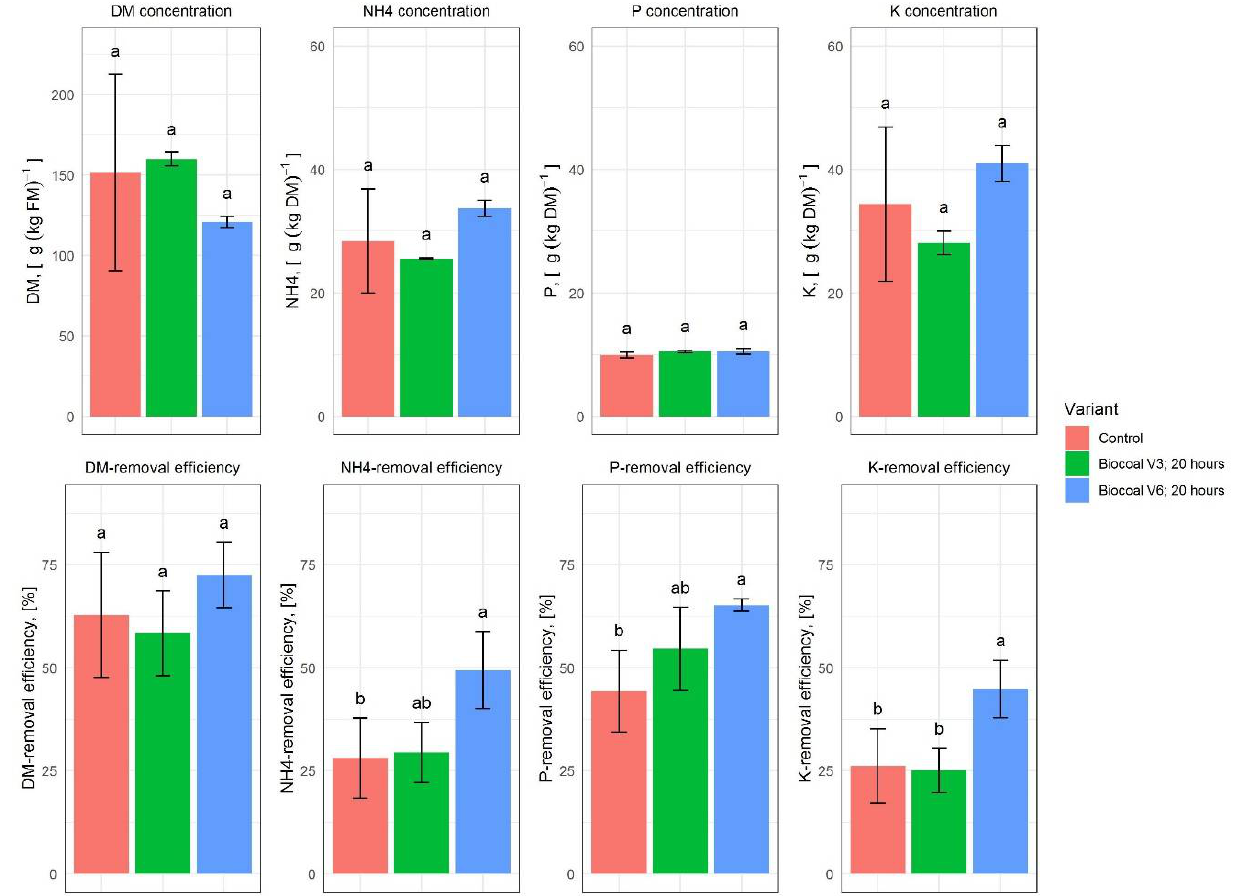
Figure 9. Comparison of the control variant (untreated digestate) with the two most promising additive variants and their best reaction times. Results were obtained in laboratory experiments. The upper diagrams show the concentrations. The lower diagrams show the removal efficiencies. Histograms are charted based on the mean values; error bars indicate the variability between the three replications. Lower case letters indicate significant differences according to the Tukey test.